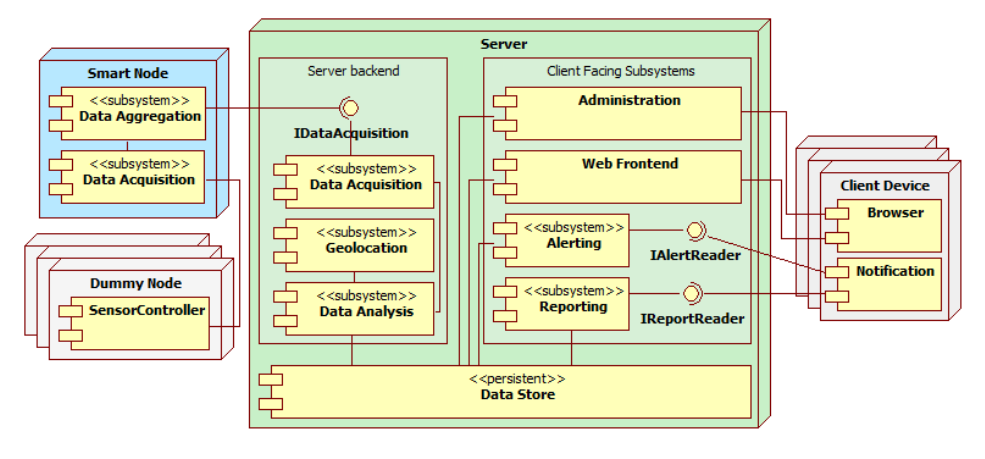
Figure 7. Software architecture of the system [5] (IEEE 978-1-5386-3368-7/17/$31.00 c (cid:13)